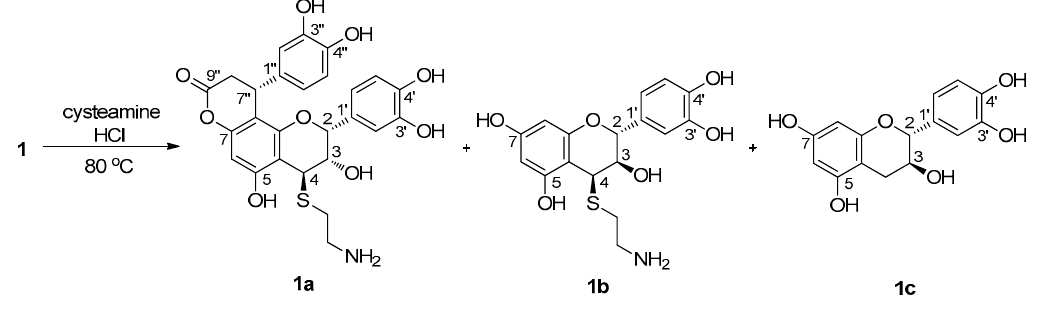
Figure 3. Acid-catalyzed thiolysis of 1 .